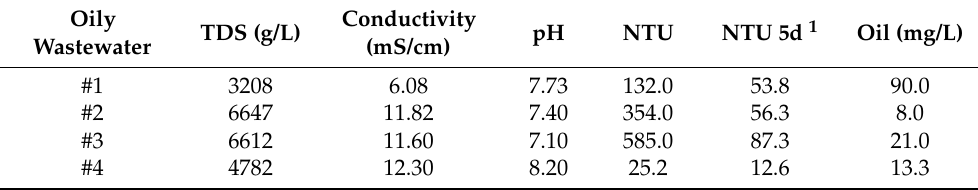
Table 1. Characteristics of real oily